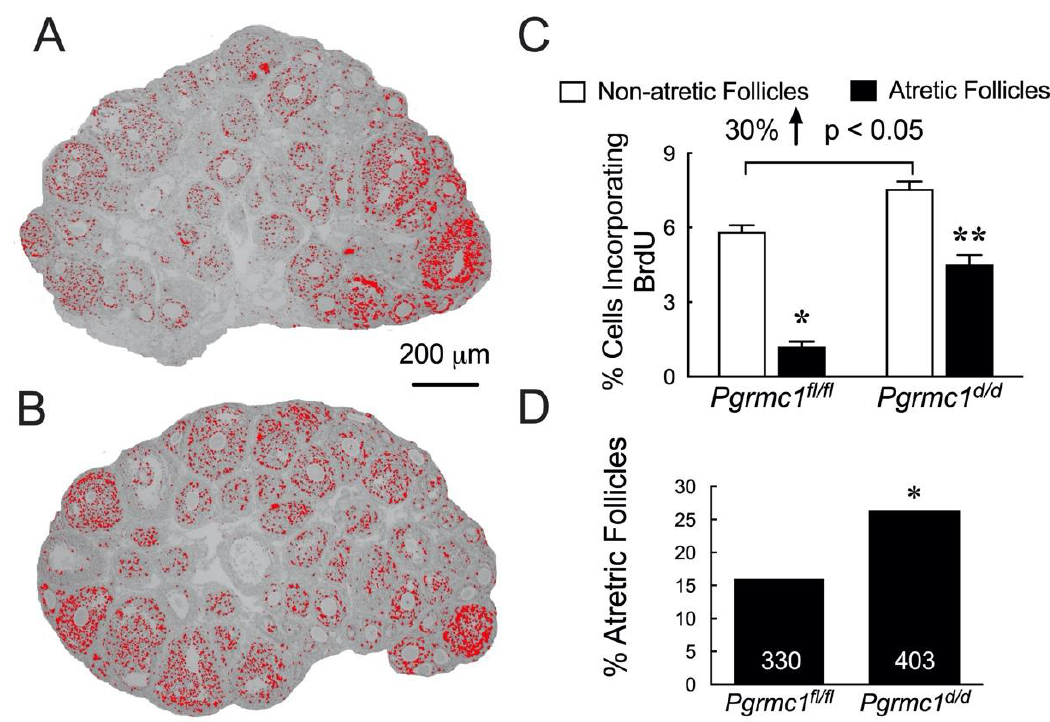
Figure 7. BrdU incorporation in the granulosa cells of nonatretic and atretic follicles of immature Pgrmc1 fl/fl and Pgrmc1 d/d mice. Panels ( A ) and ( B ) are low magnification images of the ovaries of Pgrmc1 fl/fl and Pgrmc1 d/d mice in which the cells incorporating BrdU are pseudo colored in red. Quantitative estimates of the percentage of granulosa cells incorporating BrdU in all sized non-atretic and atretic follicles of Pgrmc1 fl/fl and Pgrmc1 d/d mice is shown in panel ( C ) * indicates a significant decrease in atretic follicles compared to non-atretic follicles of Pgrmc1 fl/fl mice; ** indicates a significant decrease in decrease in atretic follicles compared to non-atretic follicles of Pgrmc1 d/d mice. The bracket refers to a 30% increase in percentage of cells incorporating BrdU in the Pgrmc d/d mice compared to the Pgrmc1 fl/fl mice. The percentage of nonatretic and atretic follicles/ovary is shown in panel ( D ) (* indicates a significant increase in the percentage of atretic follicles in Pgrmc1 d/d mice compared to Pgrmc1 fl/fl mice. Data taken from Peluso et al. [87]. PGRMC1 may also play a role in the formation of primordial follicles. In this case, progesterone inhibits the formation of primordial follicles in cultured prenatal mouse ovaries with PGRMC1 being detected in both the primordial oocytes and associated pre- granulosa cells. Depleting PGRMC1 significantly reduced the mRNA levels and